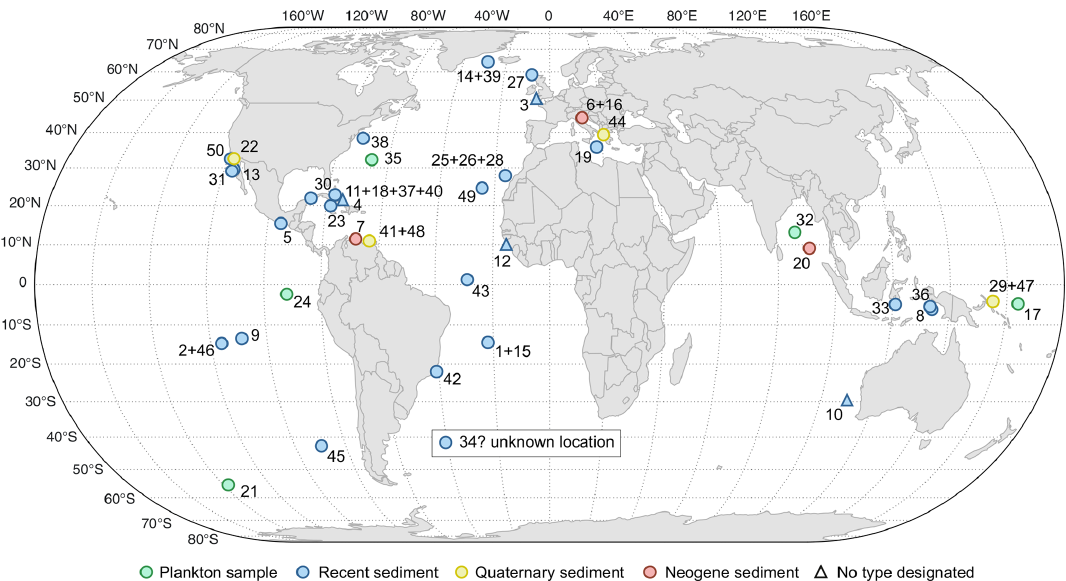
Figure 3. Location and nature of material from which types of extant species of planktonic foraminifera have been derived. Numbers refer to species as listed in Table 2. Triangles refer to the origin of type material in instances where no type has been formally designated. Question mark indicates an instance where the type locality could not be identified precisely.